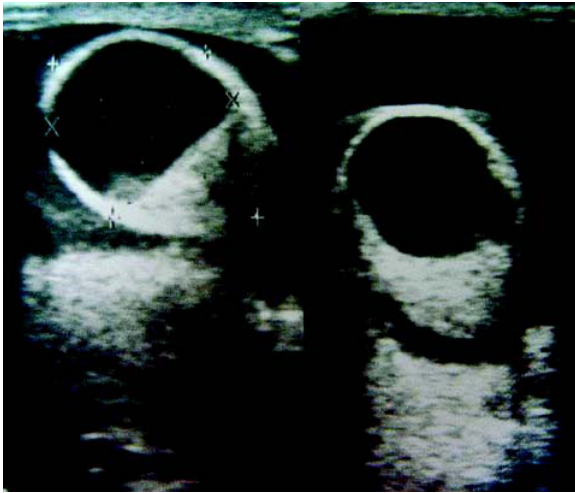
Figure 1 – Paratesticular solid hypoechoic mass.